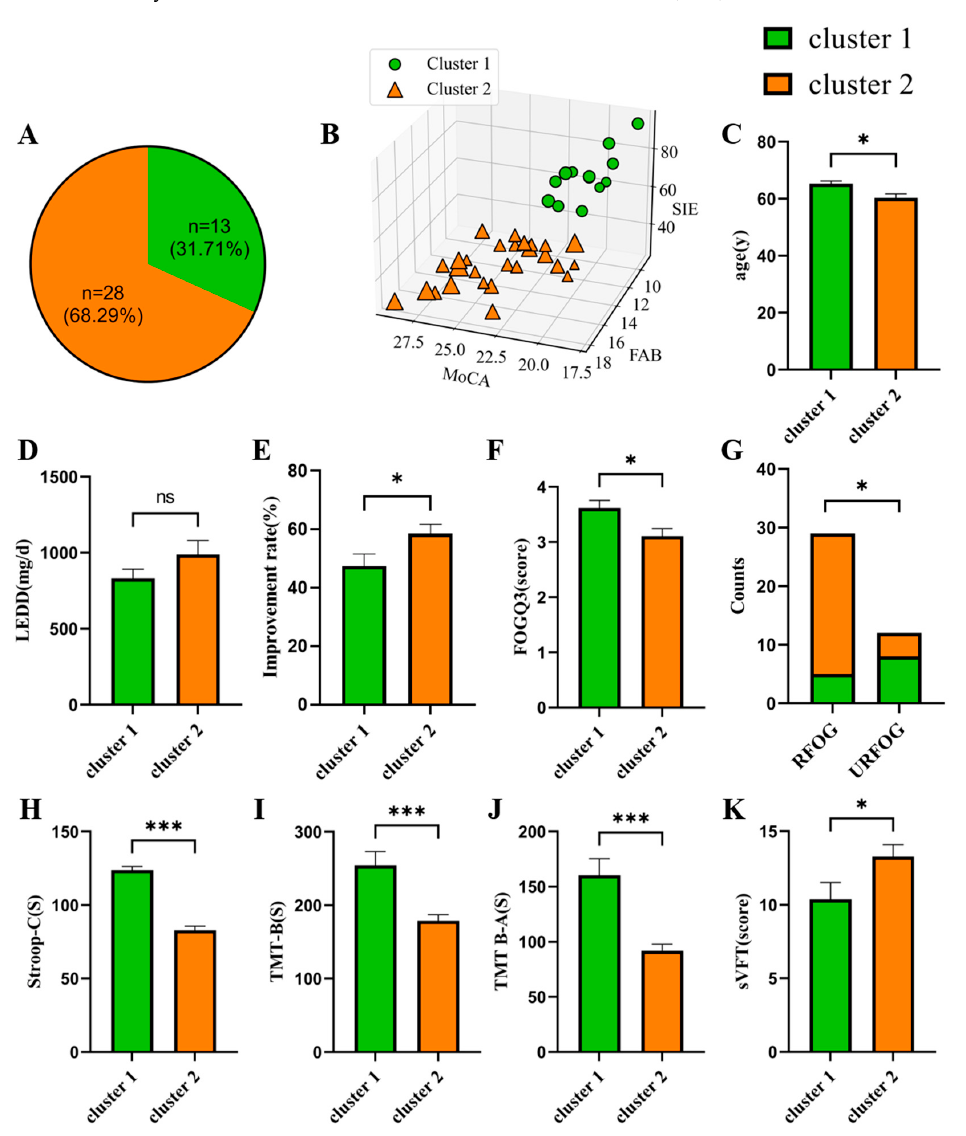
Figure 1. Results of cluster analysis in FOG and comparisons of the two clusters. ( A ) Pie charts showing proportions of clusters in FOG. ( B ) Results of cluster analysis are displayed using differen- tiation including MoCA, FAB and SIE, and the size of shapes (green circles and orange rectangles) represent the score of SDMT. ( C ) The differences in age between the two clusters (independent t -test). ( D – G ) The differences in clinical assessments between the two clusters: ( D , E ) independent t -test; ( F ) Mann–Whitney U test; ( G ) Chi-square test). ( H – K ) The differences in cognitive performance between the two clusters (independent t -test). p values shown represent an analysis of difference between two clusters, * p < 0.05; *** p < 0.001; ns: p > 0.05, not significant (two-tailed). Error bar represents standard error of mean. Abbreviations: FOG = PD with freezing of gait, LEDD = levodopa equivalent daily doses. Improvement rate was calculated as follows: [MDS-UPDRS-III(OFF) − MDS-UPDRS-III (ON)]/MDS-UPDRS-III(OFF)*100%, FOGQ3 = item 3 of FOGQ, RFOG = levodopa- responsive FOG, URFOG = levodopa-unresponsive FOG, Stroop-C = Stroop Part C. SIE = Stroop Interference Effect. TMT-B = TMT Part B. TMT B-A = the time to complete TMT-B minus the time to complete TMT-A. AVLT-5 = Auditory Verbal Learning Test Part 5. sVFT = VFT (switching between category of animals and household